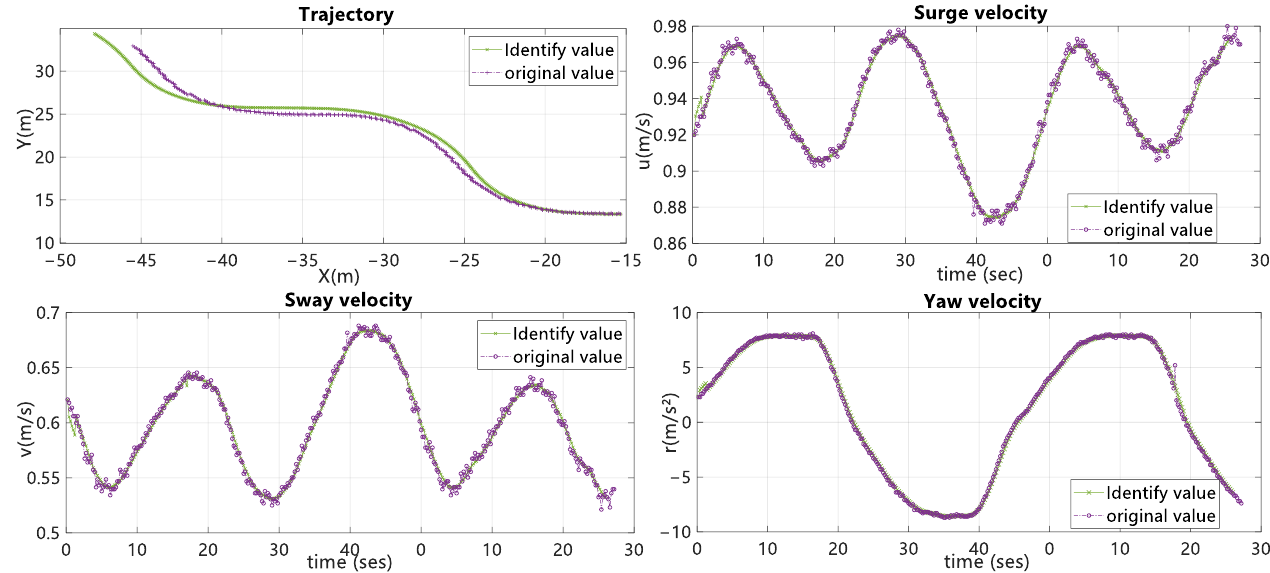
Figure 6. Identification results based on the original data.